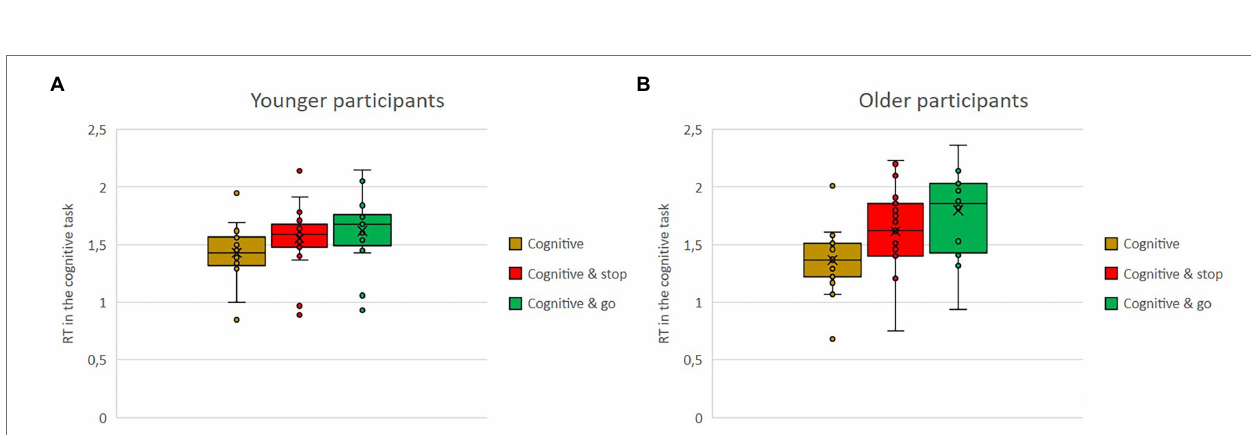
FIGURE 10 | (A,B) Means of response time in the visual secondary task, as single vs. dual-task conditions with either the stop or the go task for the older and the younger group.